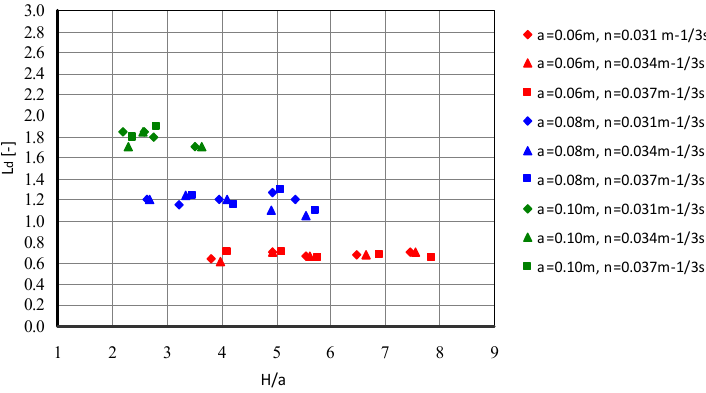
Figure 7. Changes in the L d distance between the gate and the cross-sections, wherein the measured downstream water depth h d ensures that calculated flow rate equals the measured one, showed in the function of H/a. The downstream water depths thus determined were compared with the depths h measured at a distance of 3.035 m from the gate, corresponding to the downstream measurement location of the real structure (Figure 8).